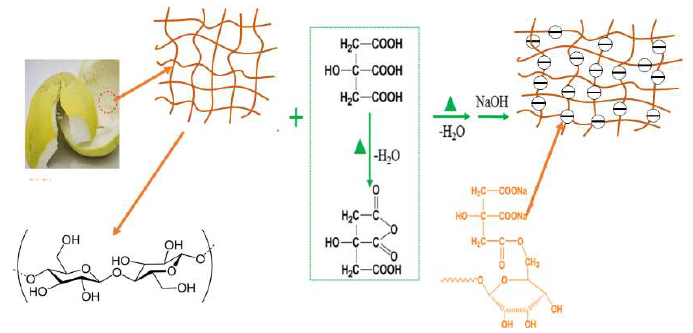
Figure 8. Schematic diagram for the MPPL preparation.